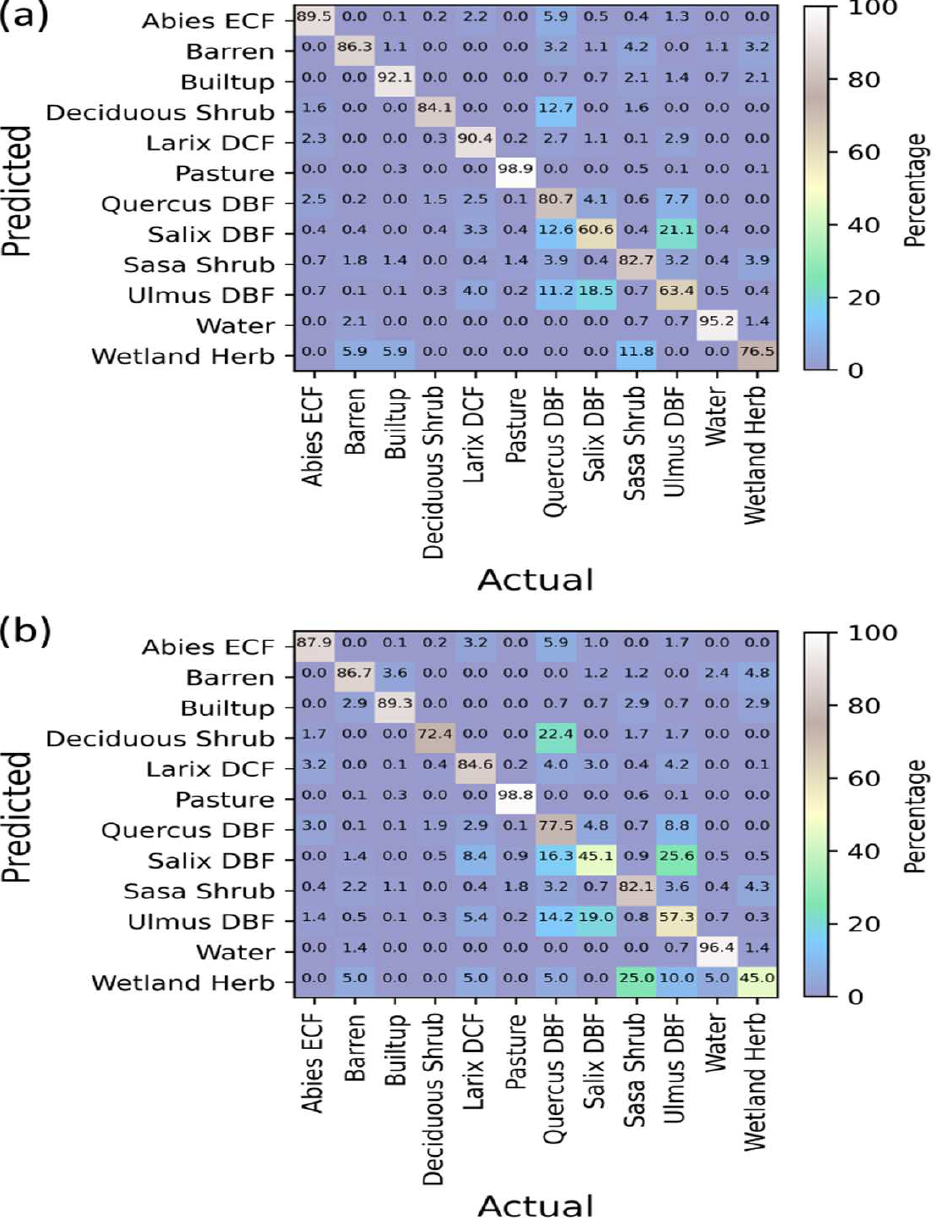
Figure 11. Performance of the ultra-resolution suite ( a ) over the very high-resolution suite ( b ) for the differentiation of land cover and vegetation types in the Shiranuka site using bi-seasonal images.